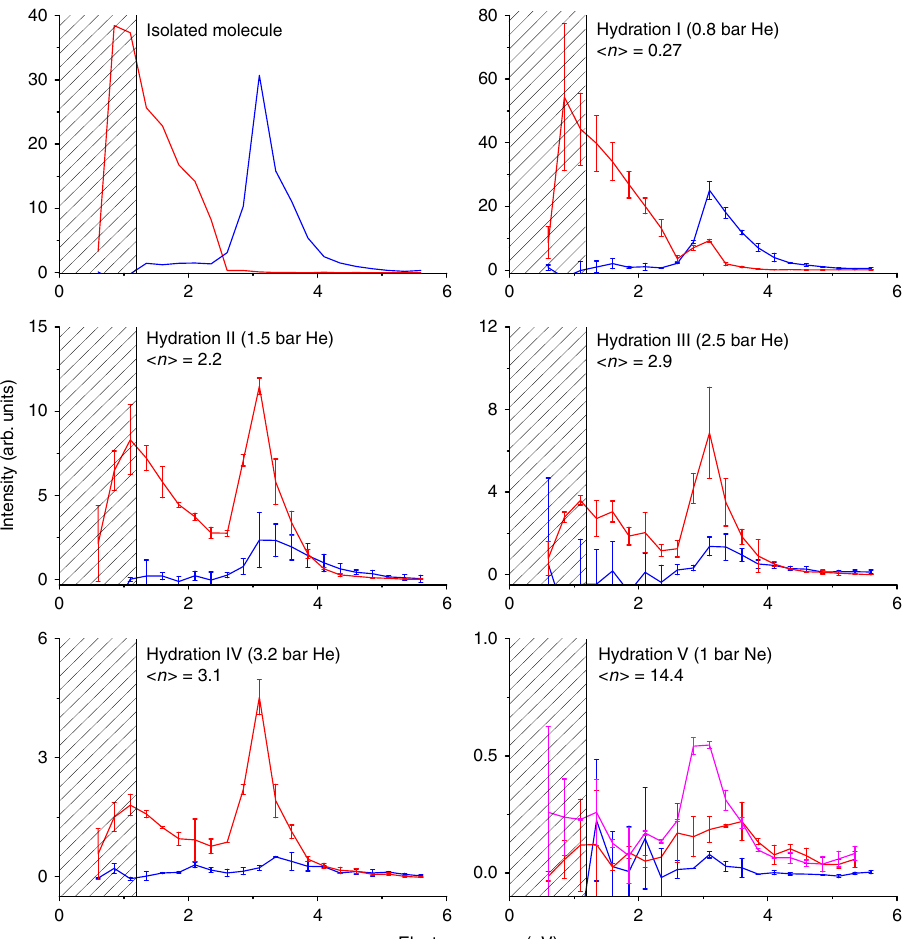
Fig. 4 Closing of the most intense DEA channel with hydration — energy dependence. Energy dependent ion yields for the formation of NO 2 − (blue) and parent NIMO − (red) ions at different hydration conditions. The level of hydration is characterised by the mean number < n > of water molecules attached to the parent anion in NIMO(H 2 O) n − clusters. At the highest hydration conditions, we are showing also the yield for m/z = 280 NIMO(H 2 O) 3 − anion (pink). The shape of the ion yield curve in the patterned part of the spectra (below about 1.2 eV) is in fl uenced by the decrease of the electron current in the cluster beam setup, see ref. 40 for details. The statistical uncertainty described by the standard deviation is shown as error bars, see data analysis section for more details. Source data are provided as a Source Data fi